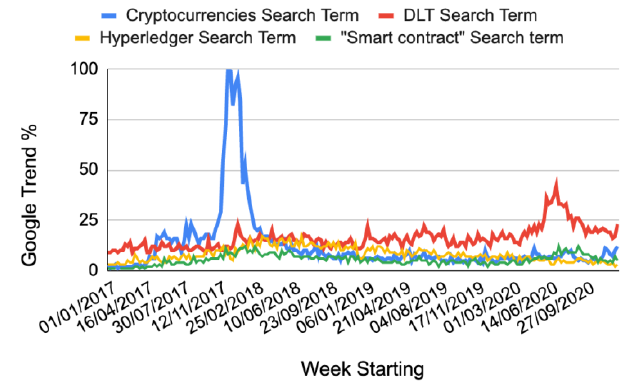
Figure 14: Google search term trend results for ‘Cryptocurrencies’, ‘DLT’, ‘Hyperledger’ and ‘Smart contract’.